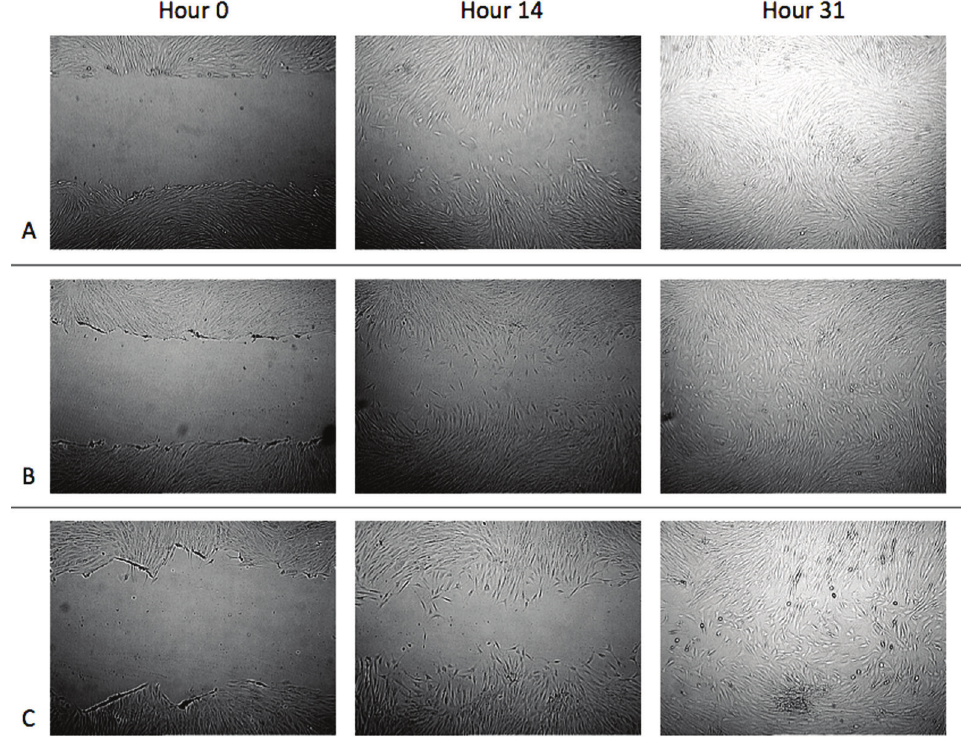
Figure 2. Two-dimensional scratch wound assay. Fibroblast migration on ( A ) 3.0 mg/mL collagen, ( B ) 5 mg/mL plasminogen depleted fibrin, or ( C ) polysterene substrates. The arrows on the right in Figure 1 point to the defects; there are four of them in each 3D construct. Images were taken at 2.5 × magnification using a Leica DM IRB.